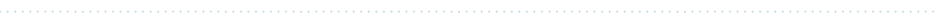
Figure 3. MALDI-MS imaging of TAG mature embryos from the WT and transgenic lines. ( A ) MS imaging of selected TAG molecular species for WT (DH12075), PDAT1 OE, GPAT9 OE, and LPAT OE. Molecular species are scaled at different intensities to highlight tissue specific distributions on a green to red color scale, indicated in the first column. Bright-field images of the tissue sections used in MS imaging experiments are shown in the first row for each genotype with the embryonic axis located at the bottom (scale bar = 500 μm). ( B ) Average mol% of TAG molecular species for each genotype summed over the tissue surface areas; embryonic axis (EA, white), inner cotyledons (IC, light gray), and outer cotyledons (OC, dark gray). (n = 4, ±